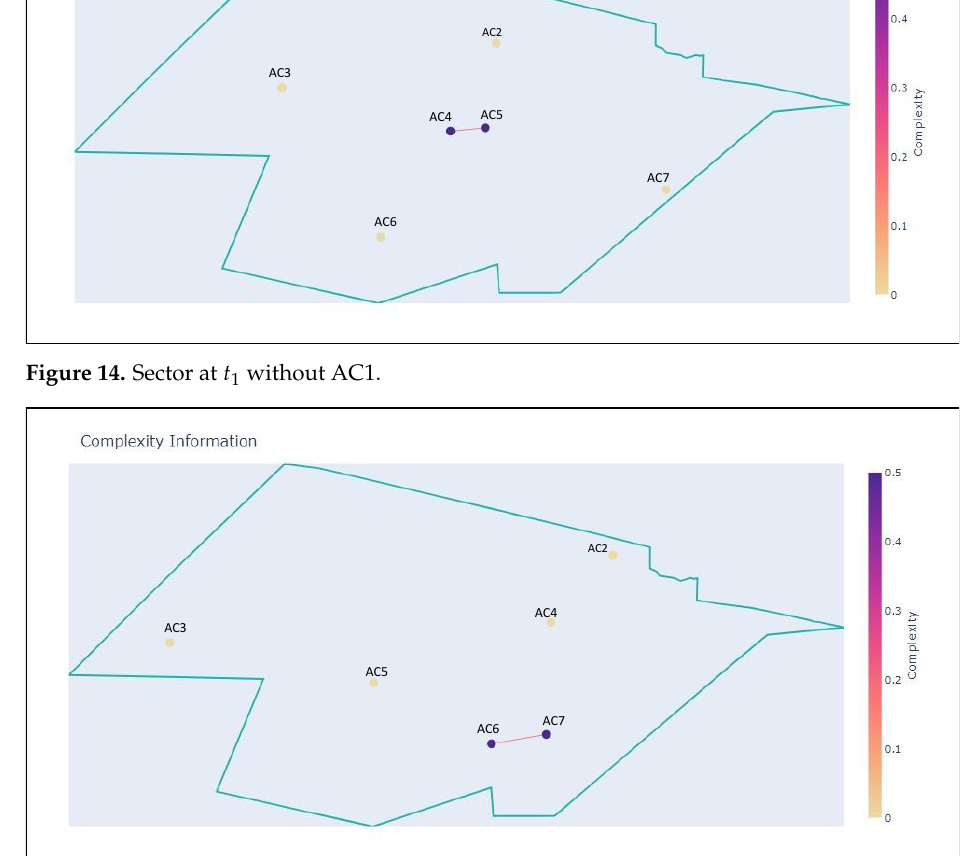
Figure 15. Sector at t 2 without